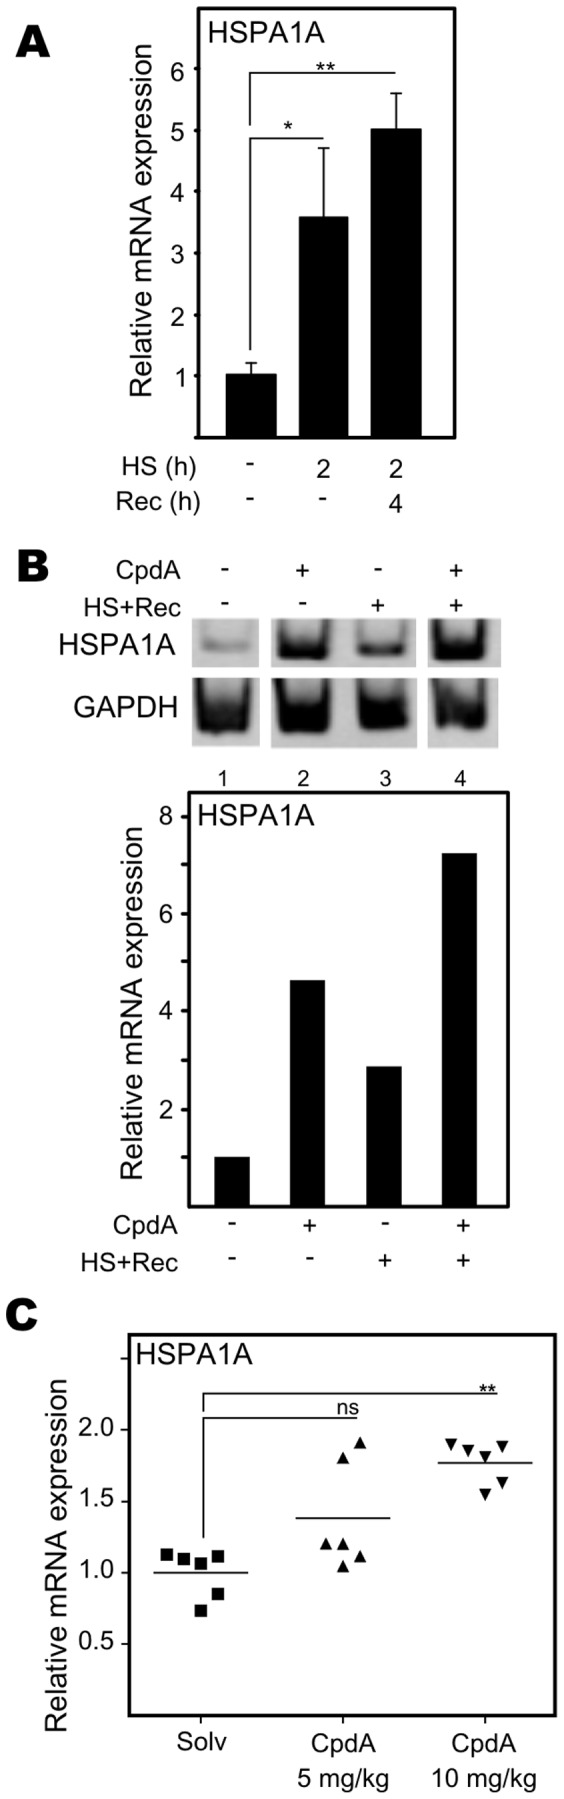
Compound A augments Hsp70 gene expression.(A) A549 cells were left untreated or were induced with heat shock (HS) at 43°C for 2h either or not followed by 4h recovery time (Rec) at 37°C. Isolated total RNA was subjected to RT-qPCR for the detection of HSPA1A, normalized to cyclophilin housekeeping control. The non-induced condition was set as 1 to allow ratio comparisons. Statistical analysis (ANOVA with Tukey’s multiple comparison post test) was performed for selected pair wise comparisons (ns not significant; *p<0.05; ** p<0.01). These results are representative of three independent experiments. (B) A549 cells, treated with solvent (Solv) or CpdA (10µM), were either incubated at 37°C for 6 hours or subjected to the following temperature protocol : 2 hours at 37°C (pre-induction), followed by 2 hours at 43°C heat shock (HS) and lastly 2 hours at 37°C (recovery; Rec). Isolated total RNA was subjected to RT-PCR for the detection of HSPA1A and control GAPDH gene expression levels. The displayed bands were detected from one single gel. The respective bands were quantified using ImageJ software and normalized to GAPDH control expression levels. Solv was set as 1 and all other conditions were recalculated relative to this condition and expressed as relative mRNA expression level. The figure is representative for 2 independent experiments. (C) Eight week old female BALB/c mice were injected intraperitoneally with either PBS as a control or CpdA dissolved in PBS (5mg/kg or 10mg/kg) and 24h later total skin samples were resected and their respective mRNA samples were subjected to RT-qPCR analysis assaying for HSPA1A gene expression levels and normalized to RPL13a, HMBS and ACTB housekeeping controls. The non-induced condition was set as 1 to allow ratio comparisons. Statistical analysis (Mann Whitney-U-test) was performed for selected pair wise comparisons (ns not significant; ** p<0.01).